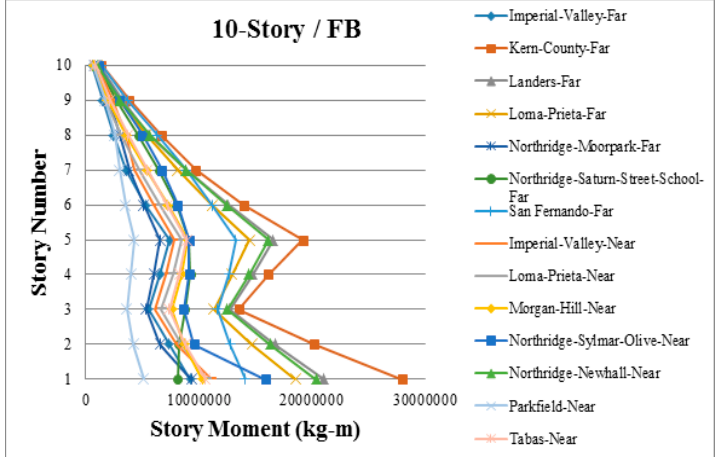
Figure 8. Peak story moments for 10-story fixed-base building.